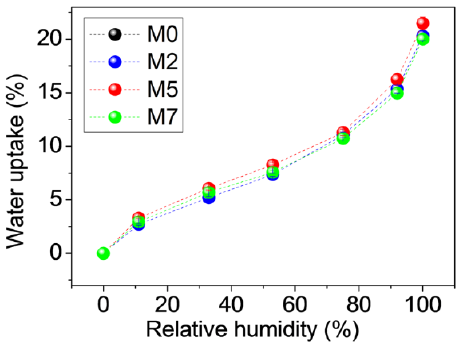
Figure 1. Water uptake (WU) values of membrane samples obtained through a relative humidity ( RH )-controlled box with the presence of appropriate saturated salt solutions.